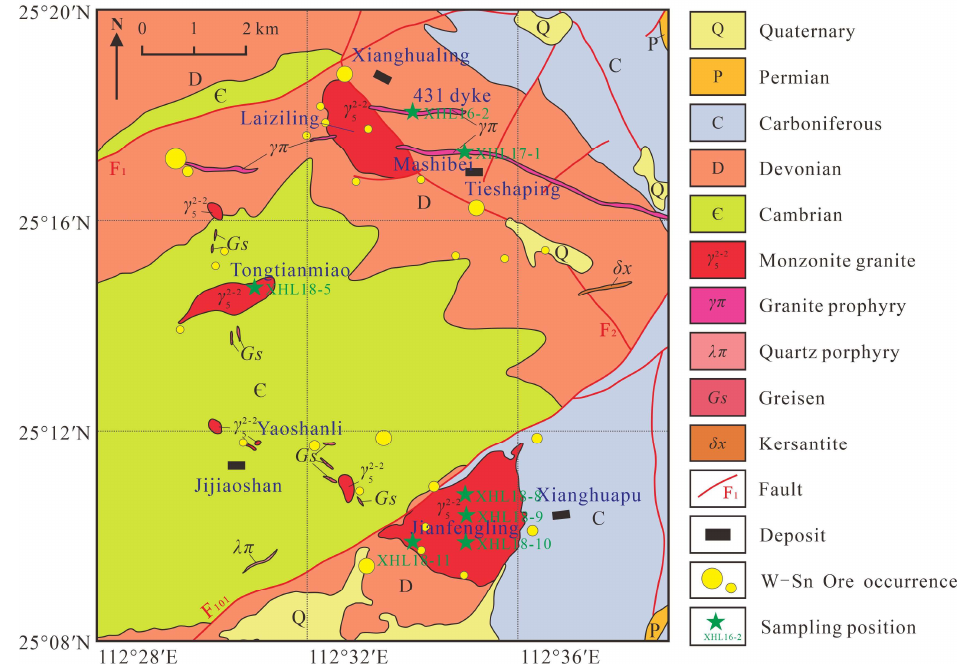
Figure 2. Simplified geological map of the Xianghualing Sn-polymetallic ore field [32].